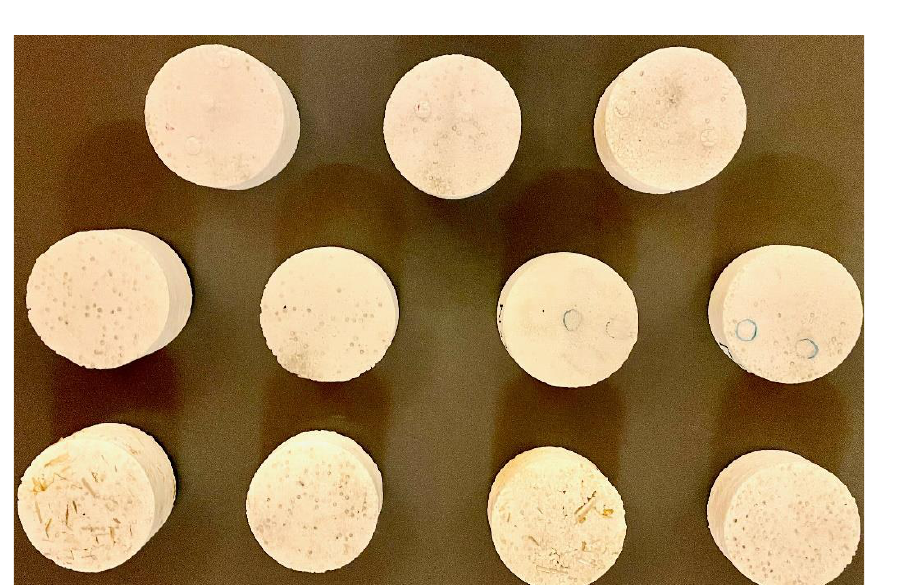
Figure 6. Chamber of pre-foaming.